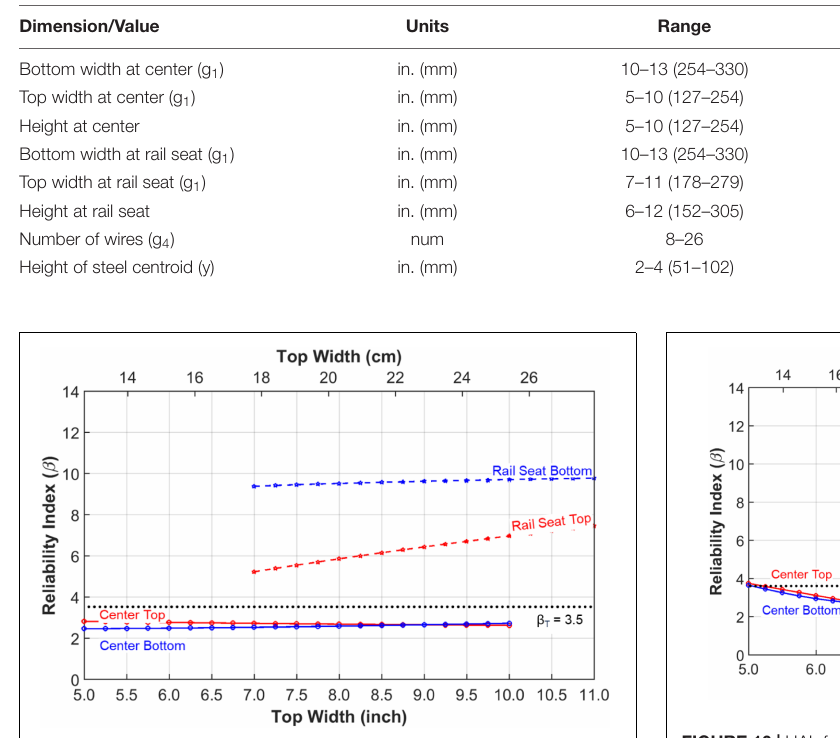
FIGURE 10 | HAL freight center bending moment structural reliability indices ( β ) as a function of height, while holding other parameters constant.